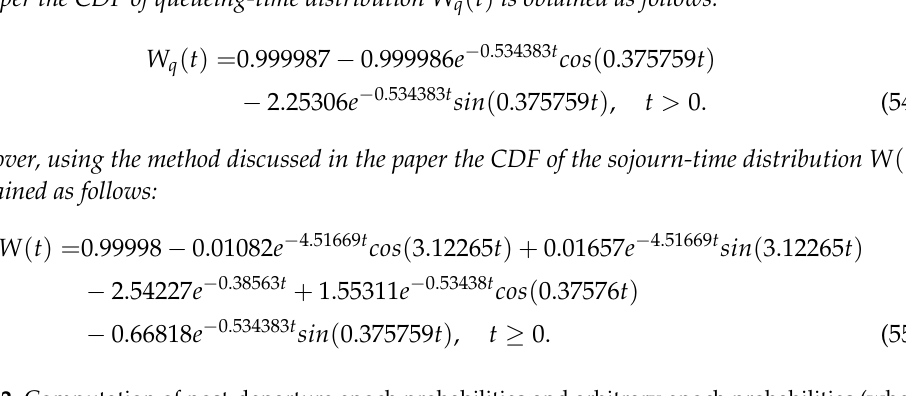
Table 2. Computation of post-departure epoch probabilities and arbitrary epoch probabilities (when the server is busy) for Example 1 with the parameters λ = 9, µ = 0.5, a = 4, b = 11, N = 20 and ρ =